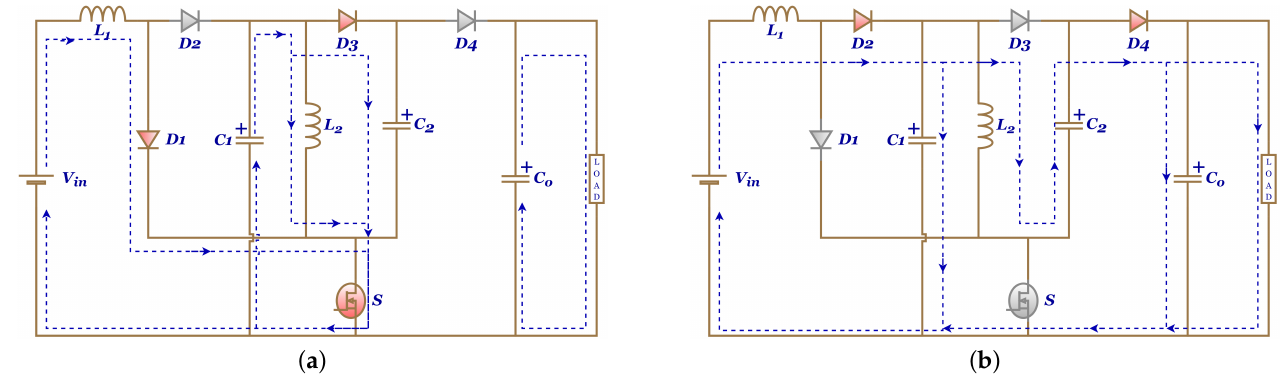
Figure 19. 3rd M-PSOL operation: ( a ) S closed, and ( b ) S